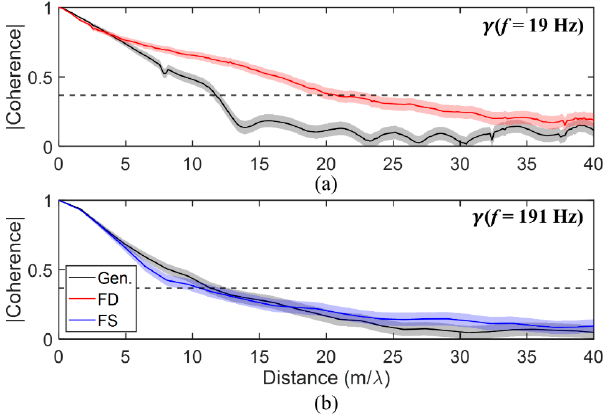
Figure 5. Coherence vs. distance (normalized by wavelength) comparison for frequencies obtainable by all three fields. The genuine in-band field is shown in black, the frequency-difference autoprod- uct is shown in red, and the frequency-sum autoproduct is shown in blue. The horizontal dotted black line is the 𝑒 (cid:2879)(cid:2869) threshold value for coherence length. Confidence intervals estimated from (10) and (11) are indicated as semitransparent regions, and the frequency used is displayed in the upper right of each panel for 60 Hz ( a ), 80 Hz ( b ), and 120 Hz ( c ).